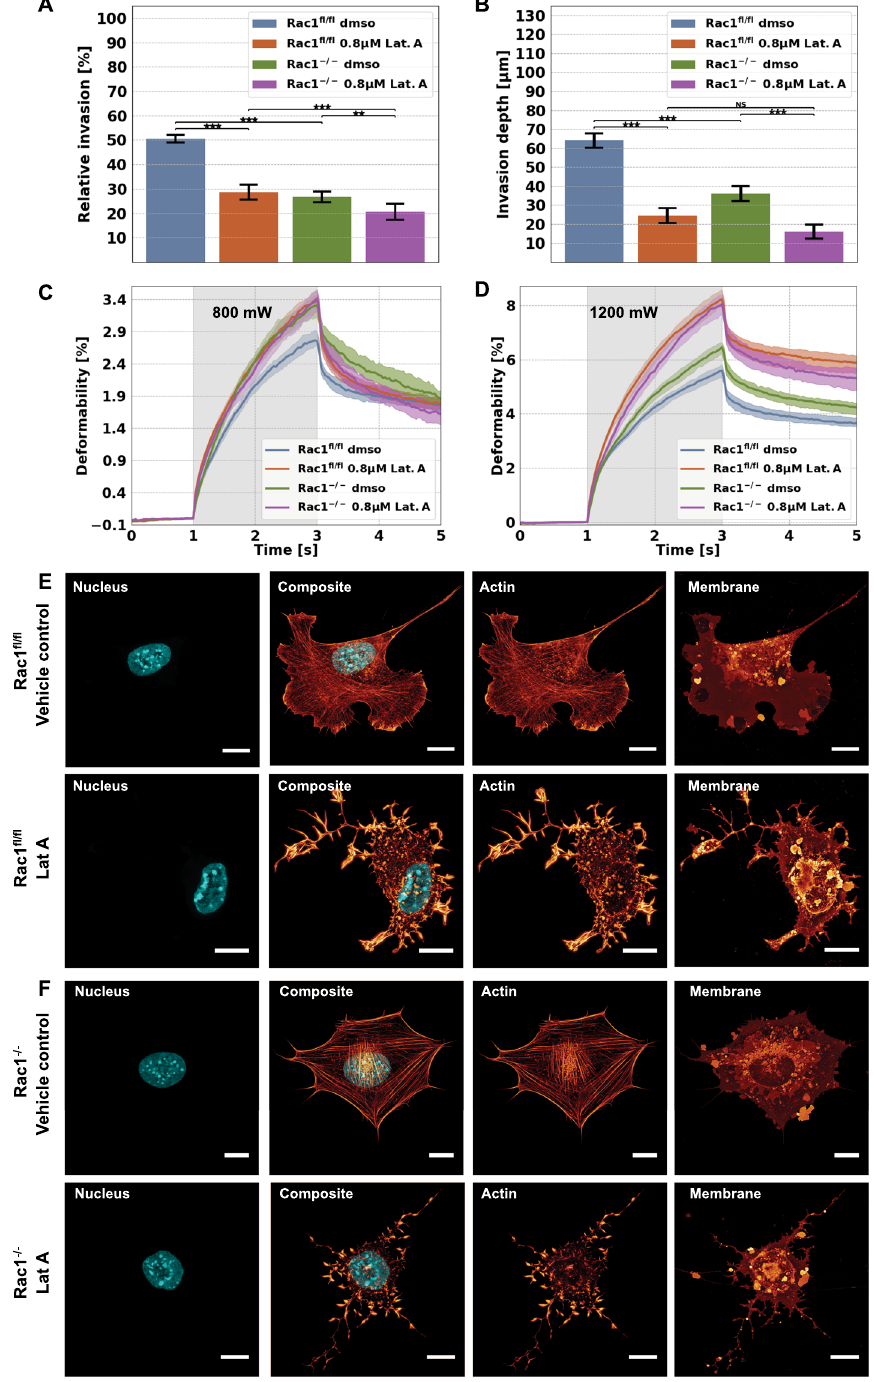
Figure 5. Impact of the actin polymerization inhibitor Lat A (0.8 µ M) on cellular motility, cellular deformability and the morphology of Rac1 − / − and Rac1 fl/fl cells. ( A ) Percentage of invasive cells and ( B ) invasion depths of Rac1 − / − and Rac1 fl/fl cells. For each condition, between 600 and 1200 cells were analyzed. ( C , D ) Long axis deformation of Rac1 fl/fl cells (blue) and Rac1 − / − cells (green) in the presence of absence of the actin polymerization inhibiting drug Lat A at low stretch laser powers of 800 mW ( C ) and high stretch laser laser powers of 1200 mW ( D ). As control serves each cell type incubated with the DMSO buffer used as solvent for the drug. ( E , F ) Nuclear shape, actin cytoskeletal structure, composite of nuclear shape and actin cytoskeleton and membrane shape of a representative Rac1 fl/fl cell ( E ) and a representative Rac1 − / − cell ( F ) in the absence (top row images) or presence of 8 µ M Lat A (bottom row images). All scale bars are 10 µ m. *** p < 0.001and NS = not